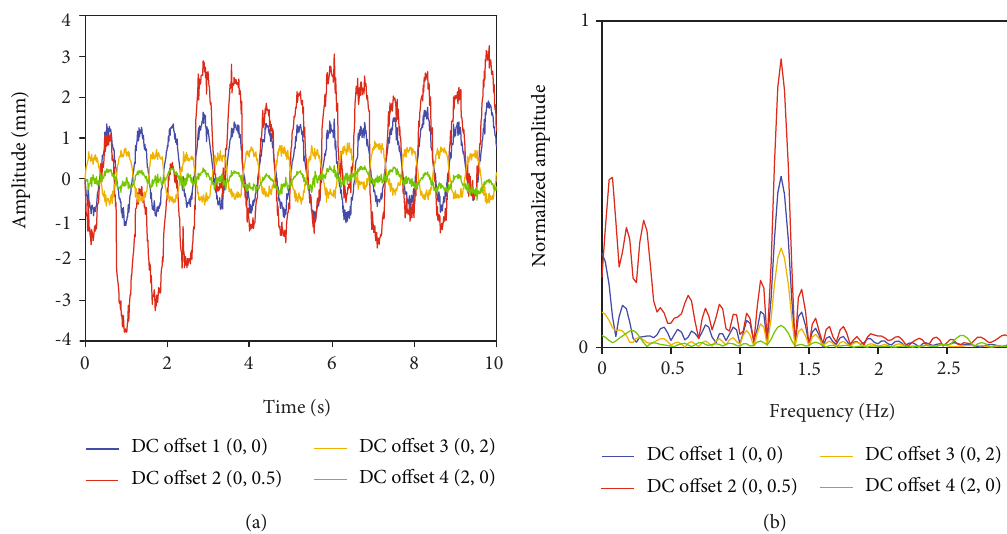
Figure 6: The demodulation result when four points are chosen for DC o ff set. (a) The result in time domain. (b) The result in frequency domain.